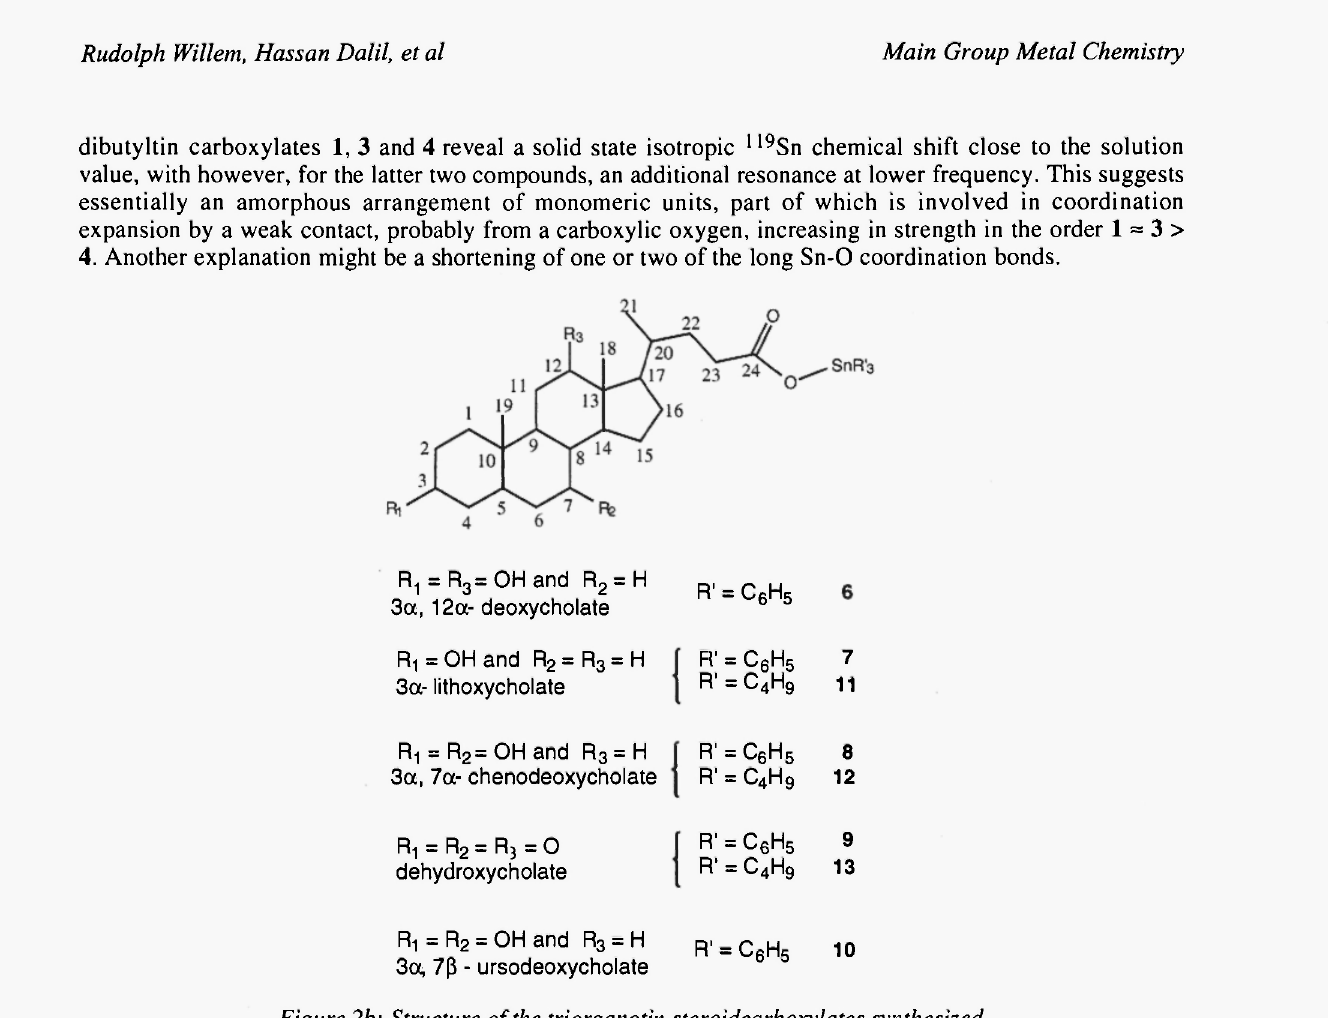
Figure 2b: Structure of the triorganotin steroidcarboxylates synthesized